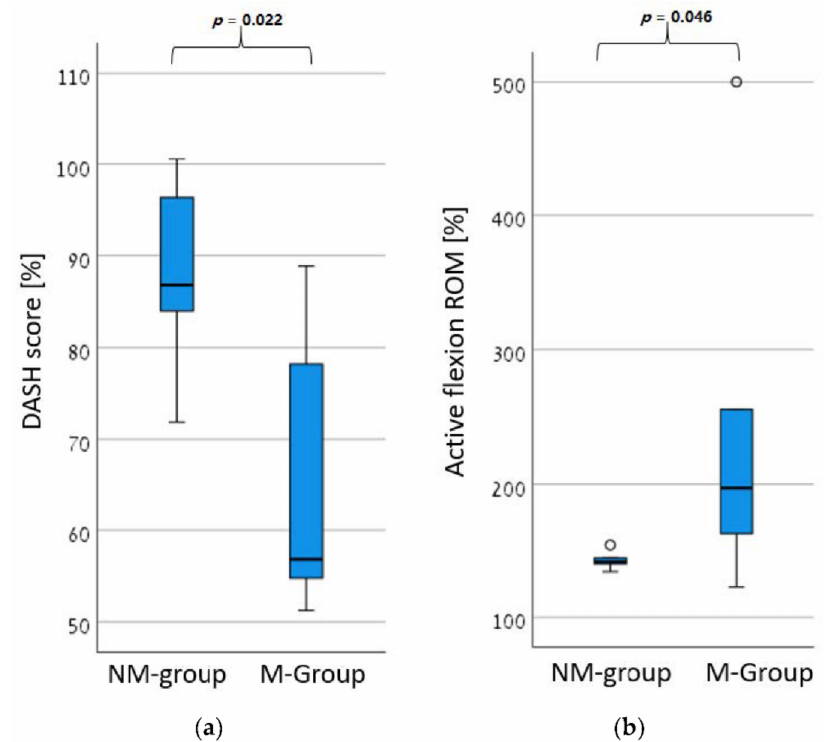
Figure 2. The percentage change (before and after the intervention) in ( a ) the Disabilities of the Arm, Shoulder and Hand (DASH) scores and ( b ) the active flexion range of motion (ROM) for both the non-manipulated feedback treatment group (NM-group; n = 6) and the manipulated feedback treatment group (M-group; n =